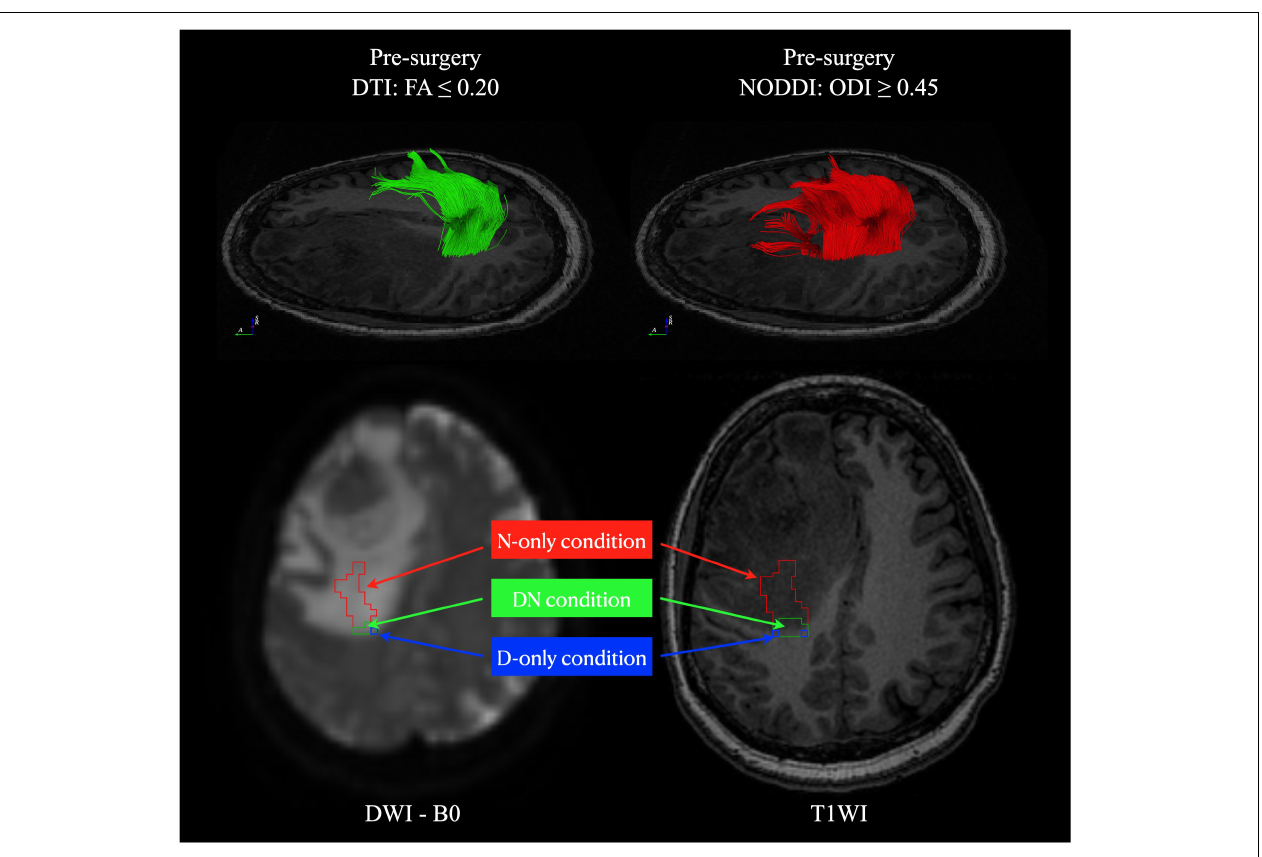
FIGURE 4 | The fiber tracts volume condition definition. Three conditions of the fiber tracts located in areas overlapping with peritumoral edema were classified in each patient: (1) DN condition: the volume of both DTI and NODDI-derived fiber tracts in the peritumoral edema (green); (2) D-only condition: the volume of only DTI fiber tracts in the peritumoral edema (blue); (3) N-only condition: the volume of only NODDI-derived fiber tracts in the peritumoral edema (red). DTI, diffusion tensor imaging; NODDI, neurite orientation dispersion and density imaging.